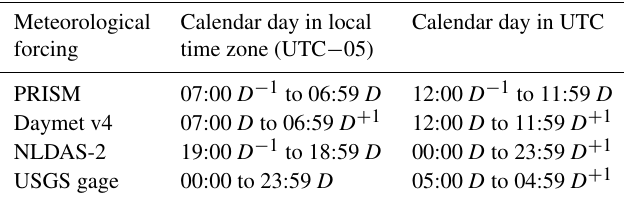
Table A1. Calendar day as defined in meteorological datasets and USGS gage.